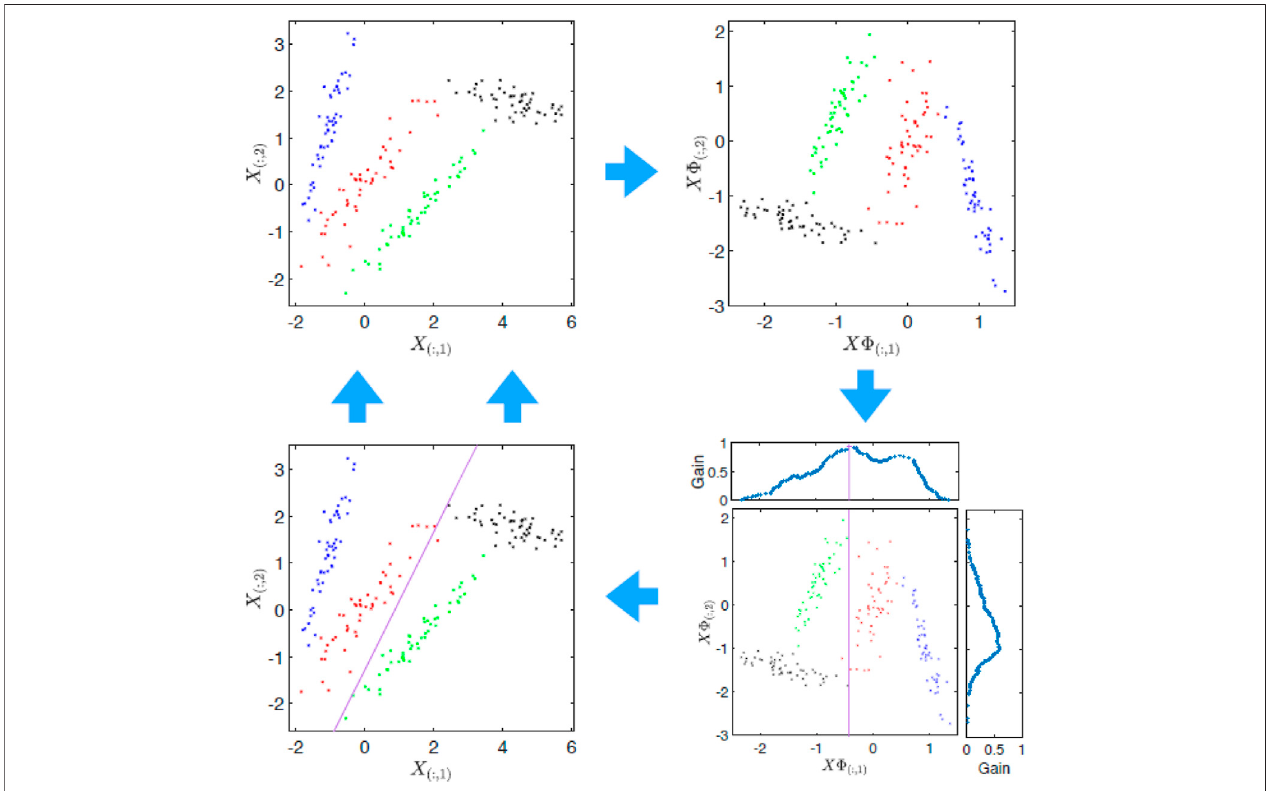
FIGURE 3 | High-level demonstration of the CCT training process for a classi fi cation task (Rainforth and Wood, 2015).